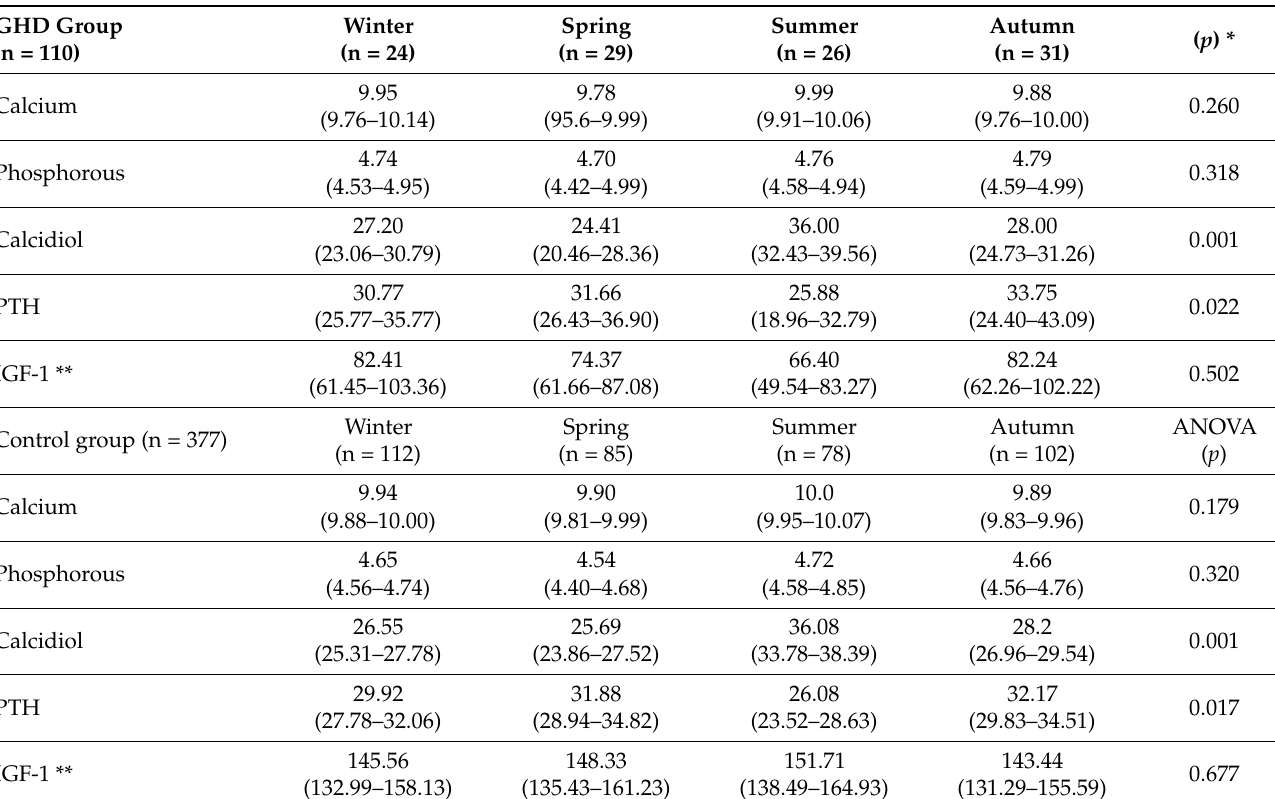
Table 1. Baseline biochemical characteristics in accordance to the season between GHD and control groups (M, 95%